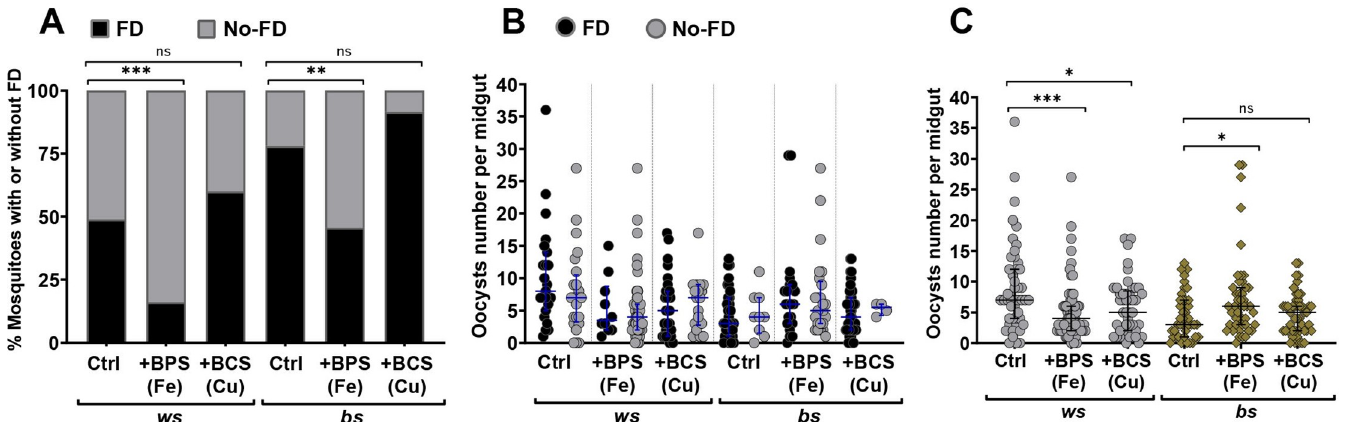
Fig 4. Effect of iron and copper chelation on follicular development and P . berghei infection in ws and bs An . albimanus . Mosquitoes were fed with sugar solution (Ctrl) or sugar solution supplemented with BPS or BCS throughout their adult life. Four days-old mosquitoes were fed with P . berghei -infected blood. A) Percentage of mosquitoes with follicular development (FD) (in black bars), and without follicular development (No-FD) (in grey bars) was determined in each treatment group. BPS treatment further suppressed oogenesis in both ws and bs mosquitoes. Data were analyzed using chi-squared test, statistical differences are indicated by asterisks, �� p = 0.002 (n = 46; X 2 = 9.6) and ��� p = 0.0002 (n = 62; X 2 = 13.6), ns = non-significant ( p > 0 . 05 ). B) Oocyst number was determined seven days post-infection and plotted against the presence or absence of FD, within treatment groups. Circles in black represent individuals with FD, circles in grey correspond to individuals with No-FD. Medians with interquartile range are indicated in blue. No statistical differences ( p > 0 . 05 )were found using Mann-Whitney U test between FD and No-FD conditions in each group. C) The same data as in the previous panel was pooled together for statistical analysis with Mann-Whitney U test comparing with control group inside each phenotype. Statistical differences are indicated by asterisks, � p = 0.0138, ��� p = 0.0004 for ws and � p = 0.0258, ns = p > 0.05 for bs comparisons between BPS and BCS, respectively, and control treatments. Medians with interquartile range are indicated in black. Infection distribution within each phenotype is described in the S4 Table.